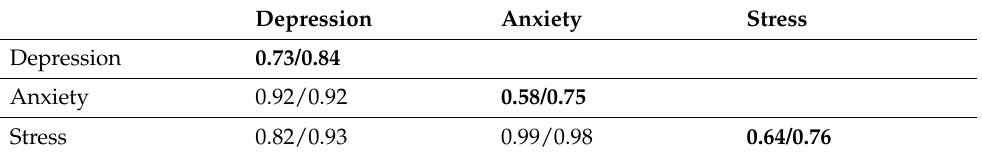
Table 4. Results of convergent and discriminant validity analysis of the